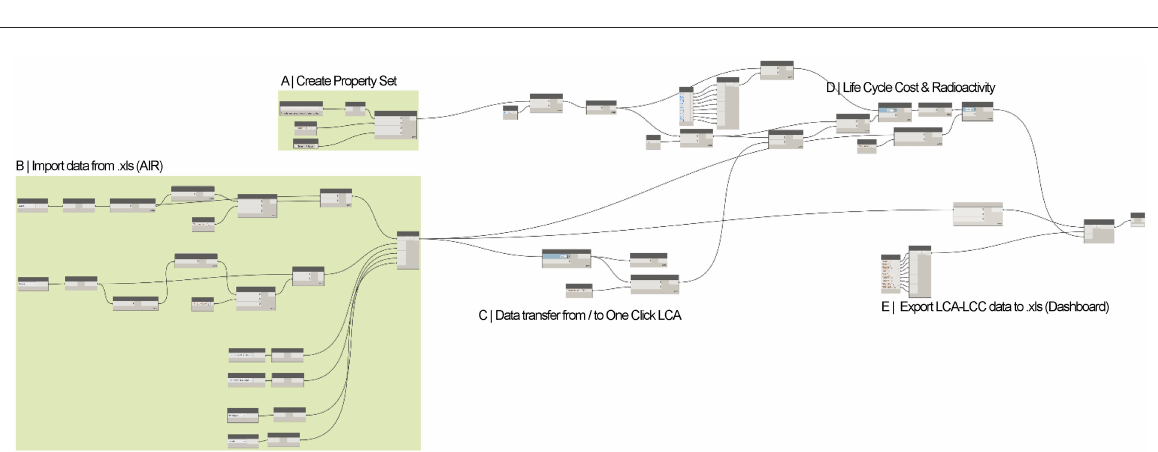
designers and BIM coordinators of the project. The dashboard also makes it possible to compare different design options